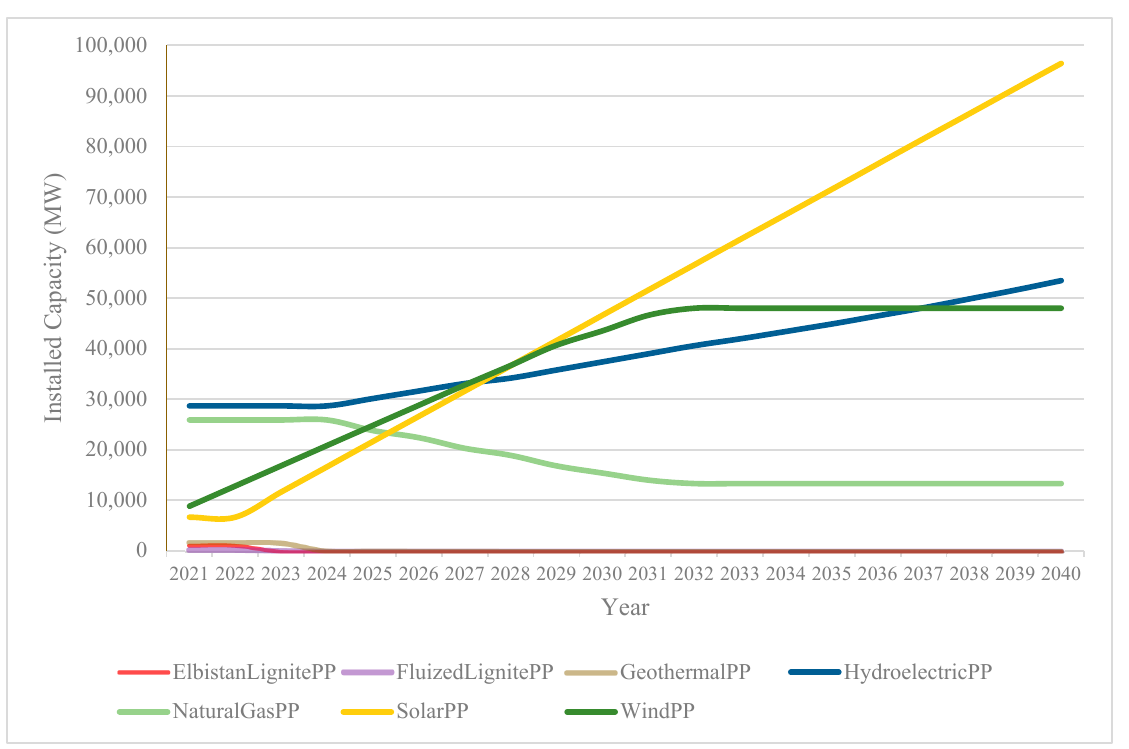
Figure 4. Installed capacities for the first scenario in the 2021–2030 horizon.